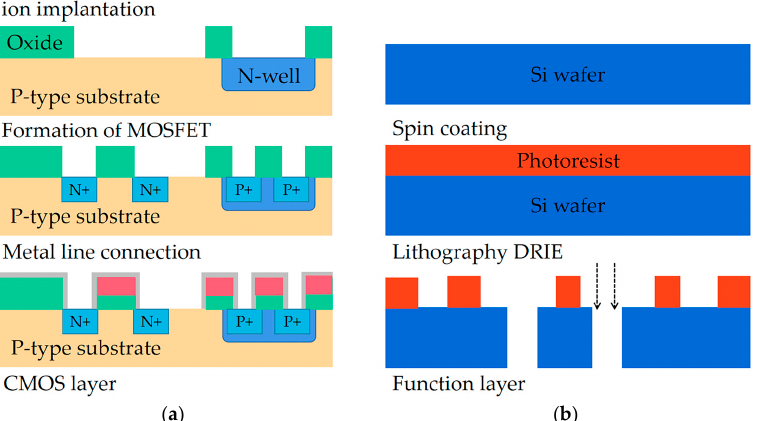
Figure 3. Fabrication of the integrated microchip. ( a ) Manufacturing fl ow diagram of CMOS layer. ( b ) Manufacturing fl ow diagram of function layer. ( b ) Manufacturing flow diagram of function